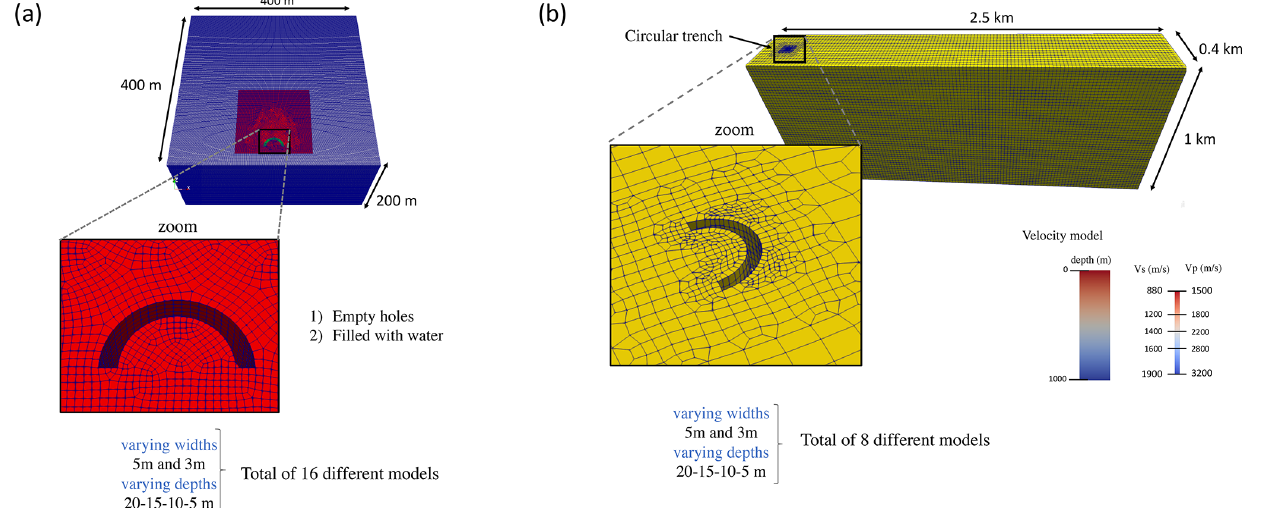
Figure 3. (a) Mesh examples of models with half-circular holes either empty or filled with water with varying width and depths as indicated. For these models the velocities are constant. For more information see text. (b) Mesh example of the large-scale models created with empty holes with varying widths and depths. For these models, P and S velocities increase with depth as indicated. Seismic stations are placed across the entire surface 35m apart.